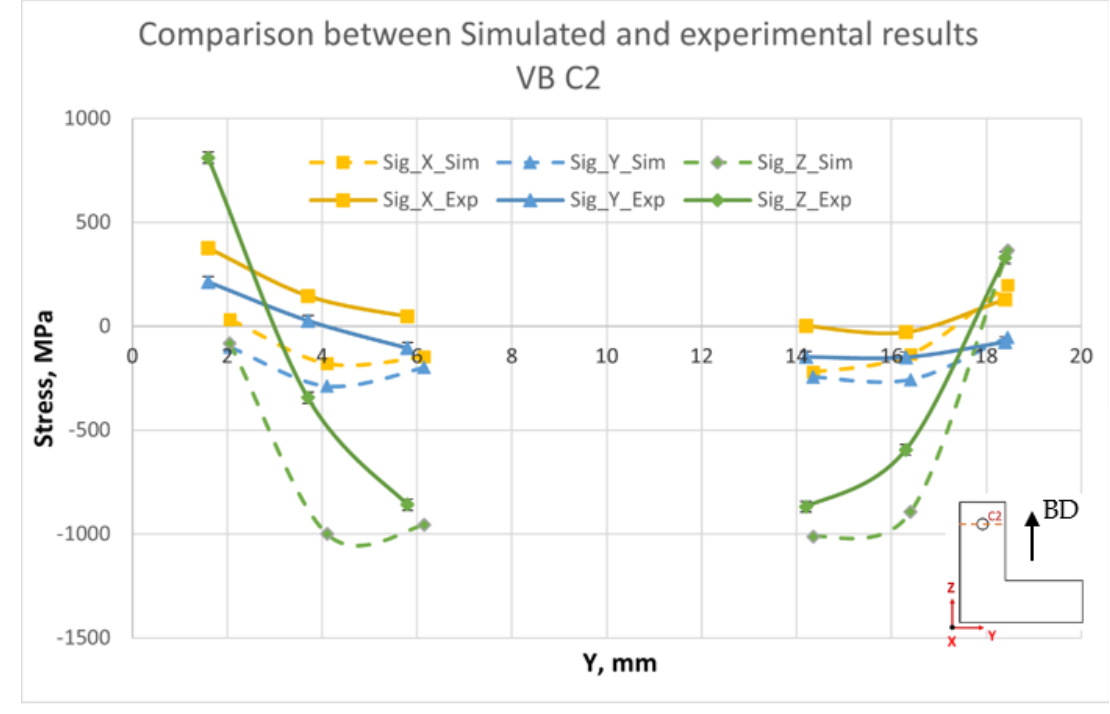
Figure 15. Comparison between experiment and simulation results for VB sample cross-section C2.